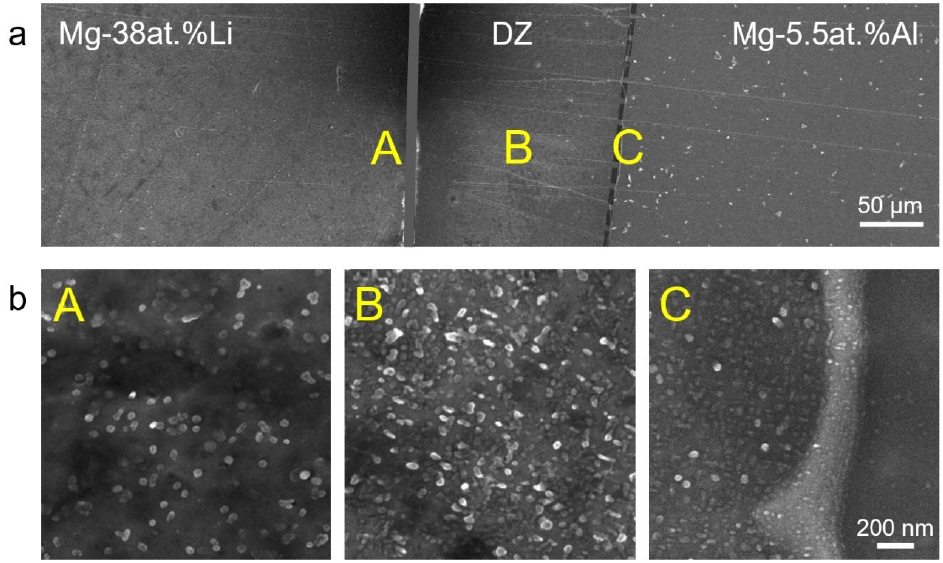
Figure 3. ( a ) SEM images of Mg–38at.%Li/Mg–5.5at.%Al diffusion couple. ( b ) Enlarged images of three areas A, B and C in ( a ). Nano ‐ sized precipitates are observed in the diffusion zone, and some similar precipitates are found near the interface in Mg–38at.%Li.